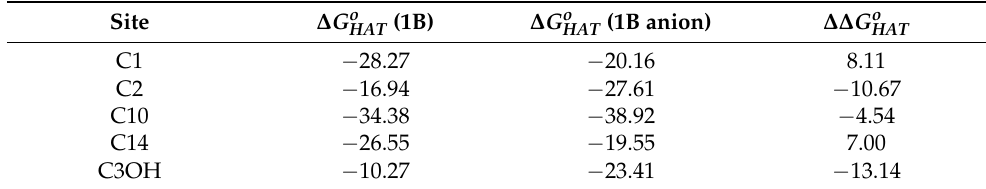
Table 1. Gibbs free reaction energies ( ∆ G o kcal mol − 1 ) computed in the gas phase of 1B and the HAT 1B anion for the scavenging of • OH via HAT from the C1, C2, C10, C14 and C3OH sites. Level of